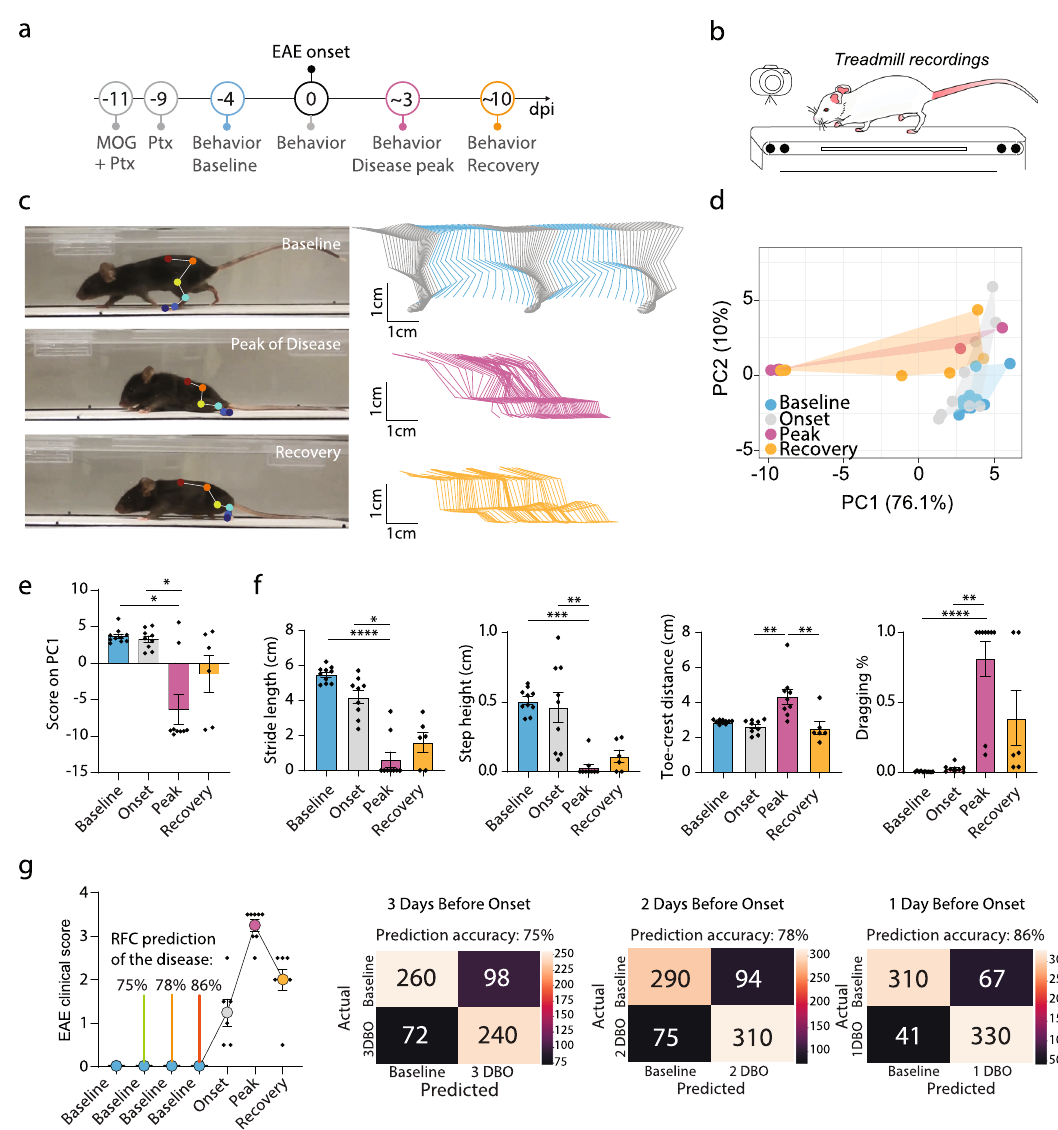
Fig. 5 ALMA monitoring of locomotor changes in mice that developed experimental autoimmune encephalomyelitis and accurate prediction of disease development during the prodromal phase. a Timeline of the EAE experiment. b Schematic of treadmill system used to record the behavior of the mice during the EAE experiment. c Photographic images of mice running on the treadmill (left) showing markerless labeling of hindlimb joints using DeepLabCut (DLC) at baseline (top), onset of disease (middle), and disease recovery (bottom), and hindlimb trajectories (right) for baseline (top), onset of disease (middle), and disease recovery (bottom). d Principal component analysis of data obtained on the treadmill and processed with the ALMA toolbox. e Plot of the PC1 scores that represent 76.1% of the variability and associated factor loadings (Kruskal – Wallis followed by Dunn ’ s test; baseline vs. peak, P = 0.0104; onset vs. peak, P = 0.0418; baseline vs. recovery, P = 0.9806; peak vs. recovery, P > 0.9999). f Quantitative evaluation of factors associated with PC1, i.e., stride length, step height, toe – crest distance, and dragging, at baseline and different stages of EAE (Kruskal – Wallis followed by Dunn ’ s test; stride length, baseline vs. peak [ P < 0.0001], onset vs. peak [ P = 0.0231], baseline vs. recovery [ P = 0.0019], peak vs. recovery [ P > 0.9999]; n = 6; step height, baseline vs. peak [ P = 0.0002], onset vs. peak [ P = 0.0020], baseline vs. recovery, [ P = 0.0382], peak vs. recovery [ P > 0.9999]; toe – crest distance, baseline vs. peak [ P = 0.0737], onset vs. peak [ P = 0.0036], baseline vs. recovery [ P = 0.0382], peak vs. recovery [ P = 0.7374]; and dragging (%), baseline vs. peak [ P < 0.0001], onset vs. peak [ P = 0.0082], baseline vs. recovery [ P = 0.0039], peak vs. recovery [ P > 0.9999]; n = 6). g EAE clinical score and prediction of the disease onset based on random forest classi fi cation in the prodromal phase (3, 2, and 1 days before onset) using ALMA. In all panels, data are presented as mean ± SEM; * P < 0.05; ** P < 0.01; *** P < 0.001. Px pixels, dpi days